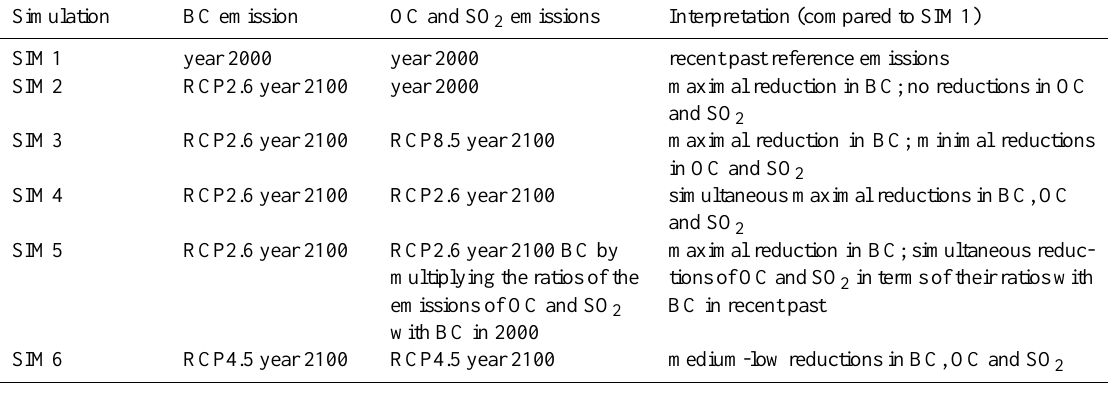
Table 1. Simulation setups.